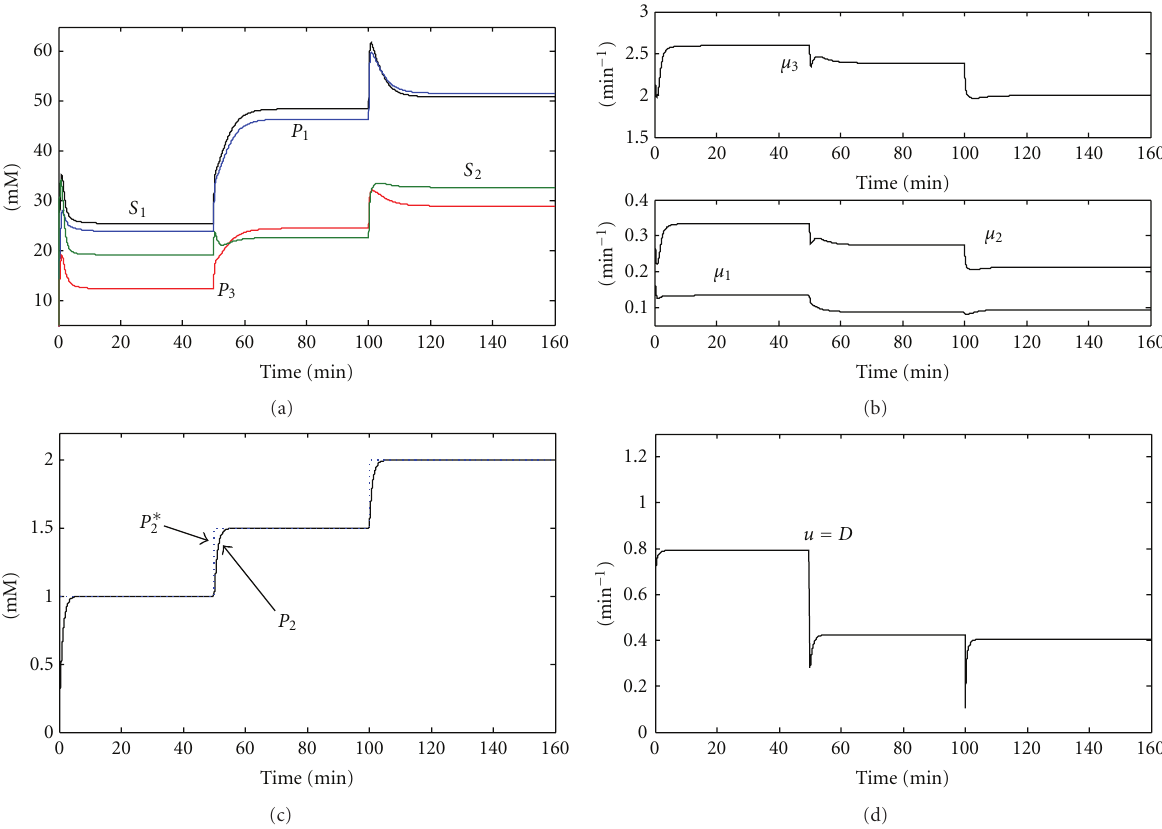
Figure 4: Simulation results—exact linearizing control law. The closed loop system was tested for a step profile of the ampicillin concentration reference. Panel (a) shows the time evolution of ξ 1 = S 1 , ξ 2 = S 2 , ξ 3 = P 1 , and ξ 5 = P 3 (i.e., 6-APA, PGME, PG, and methanol concentrations, resp.). In panel (b), the profiles of specific reaction rates μ 1 , μ 2 , and μ 3 are depicted. Panel (c) presents the output y ∗ = P ∗ y = P 2 (ampicillin concentration) versus the reference profile 2 . Panel (d) shows the control action, that is, the evolution of the dilution